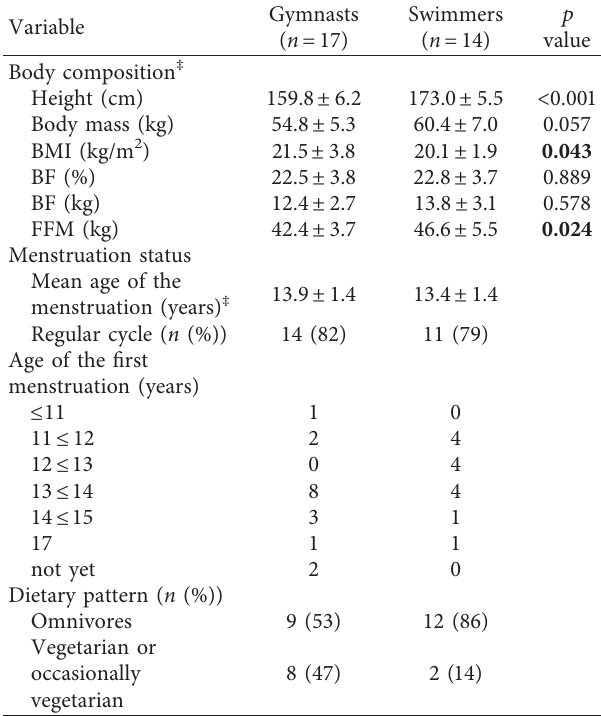
Table 1: Characteristics of gymnasts and